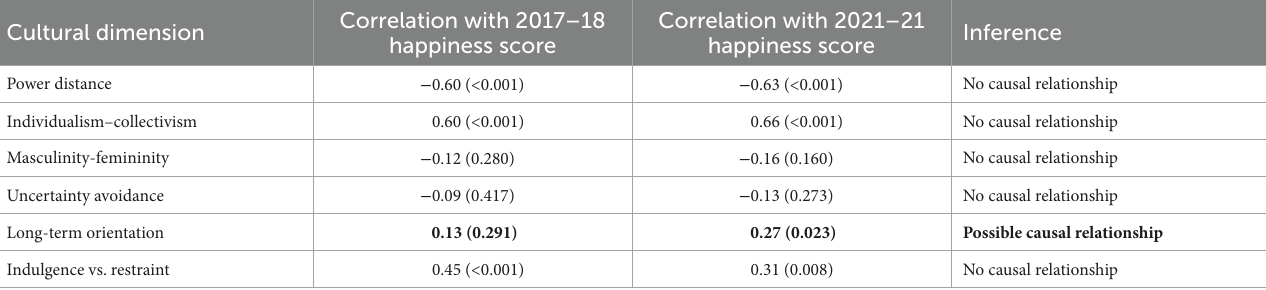
TABLE 3 Cross-lagged regression analysis of the relationship between Hofstede’s cultural dimensions and national happiness scores before and during the COVID-19 pandemic.